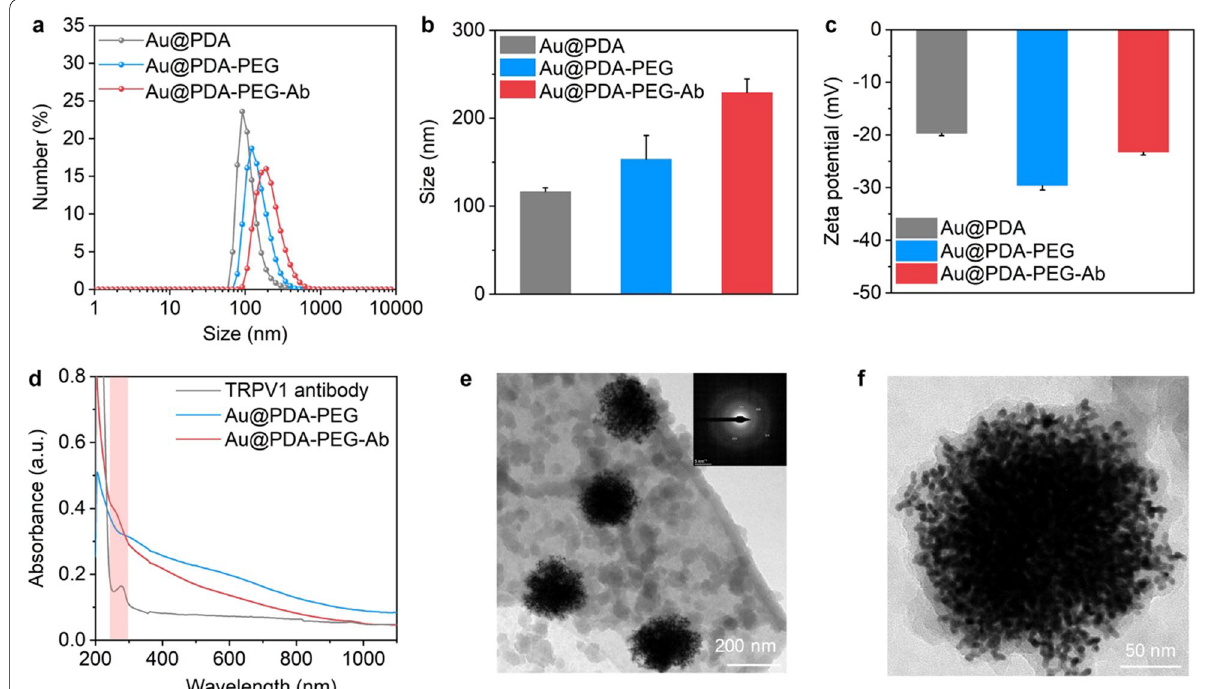
Fig. 2 Characterization of Au nanoparticles. a Size distributions of Au@PDA, Au@PDA-PEG, and Au@PDA-PEG-Ab. b Hydrodynamic sizes of Au nanoparticles (n 3). c Zeta potentials of Au nanoparticles (n = Au@PDA-PEG-Ab. e TEM images of Au@PDA-PEG-Ab nanoparticles. Inset: SAED pattern of nanoparticles. f Enlarged view of Au@PDA-PEG-Ab